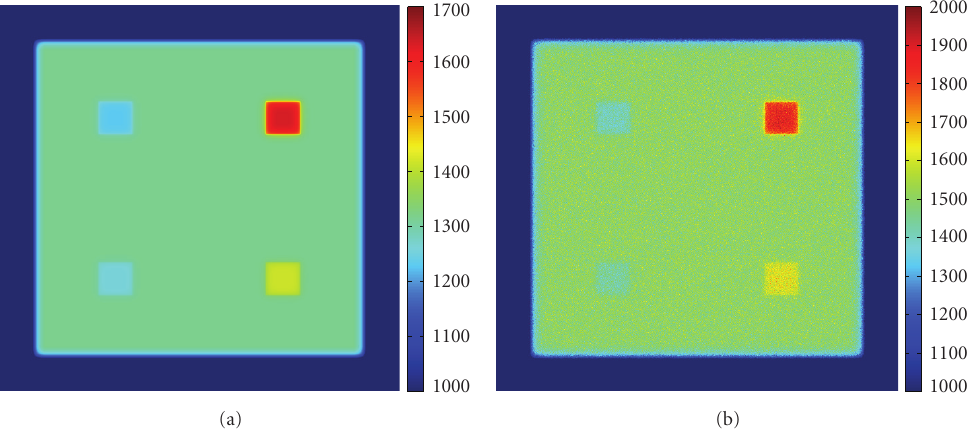
Figure 5: Numerical results on X-ray single scattering imaging. (a) A single scattering image from (6)-(7), and (b) a pure small angle scattering image from the Monte Carlo